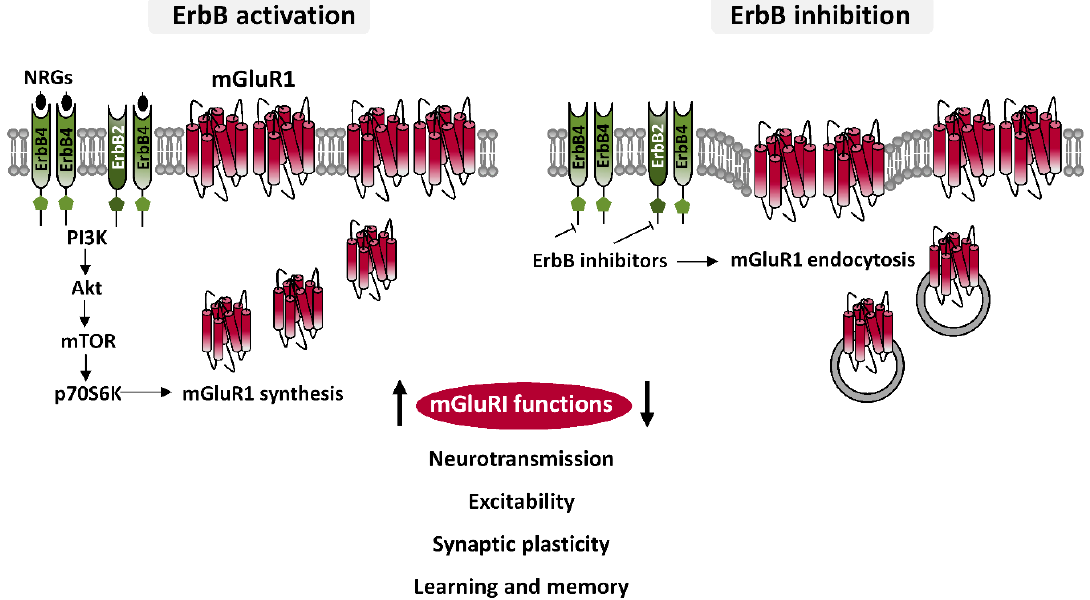
Figure 4. ErbB-dependent regulation of mGluRI. Diagram illustrating cellular mechanisms underlying ErbB-dependent regulation of mGluR1 showing that ErbB stimulation, by PI3K-Akt-mTOR pathway, induces mGluR1 synthesis and their trafficking to membrane, thus enhancing mGluR1 functions, whereas ErbB inhibition causes mGluR1 endocytosis, thus impairing mGluR1 activity. Pharmacological ErbB modulation hence can regulate different mGluRI-dependent effects, affecting neuronal depolarization, excitability, glutamatergic synaptic plasticity, learning and memory processes, as object recognition memory, and modulating in vivo activation of dopaminergic nigrostriatal pathway.